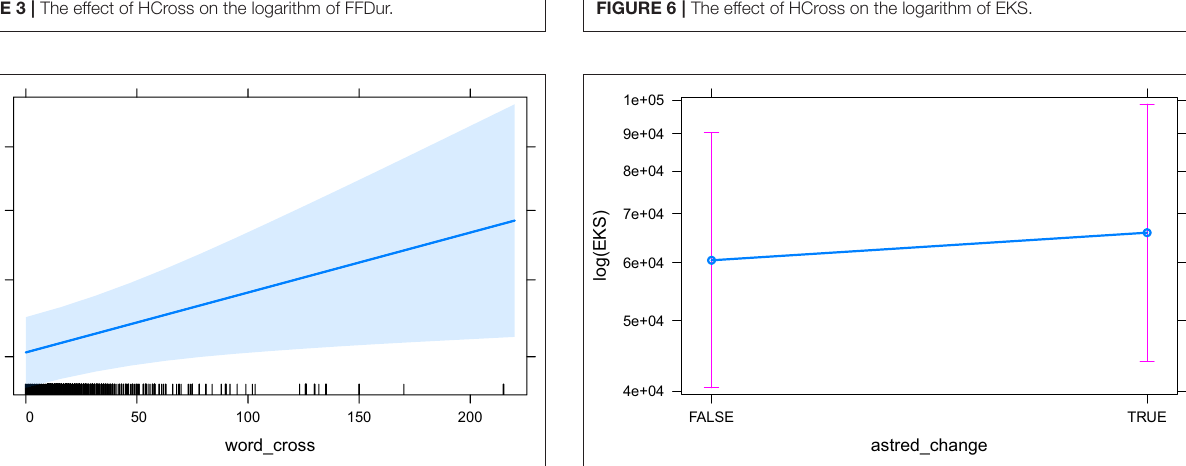
FIGURE 7 | The effect of astred_change on the logarithm of EKS.